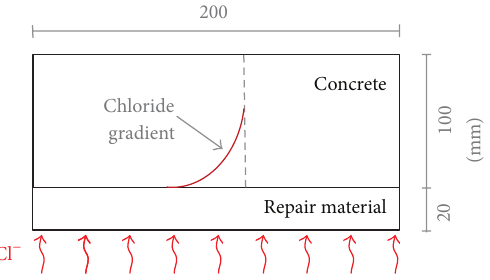
Figure 11: Laboratory storage tests with composite specimens (width: 200